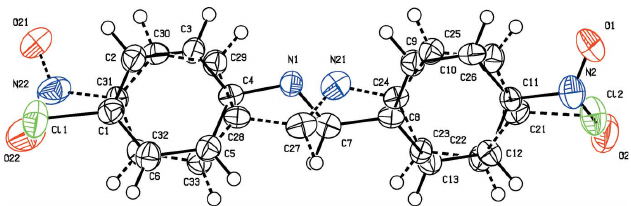
Figure 2 Molecular structure of CNBA, with atom labelling. The displacement ellipsoids are drawn at the 50% probability level. The major component is shown with solids bonds, while the minor component is shown with dashed bonds.